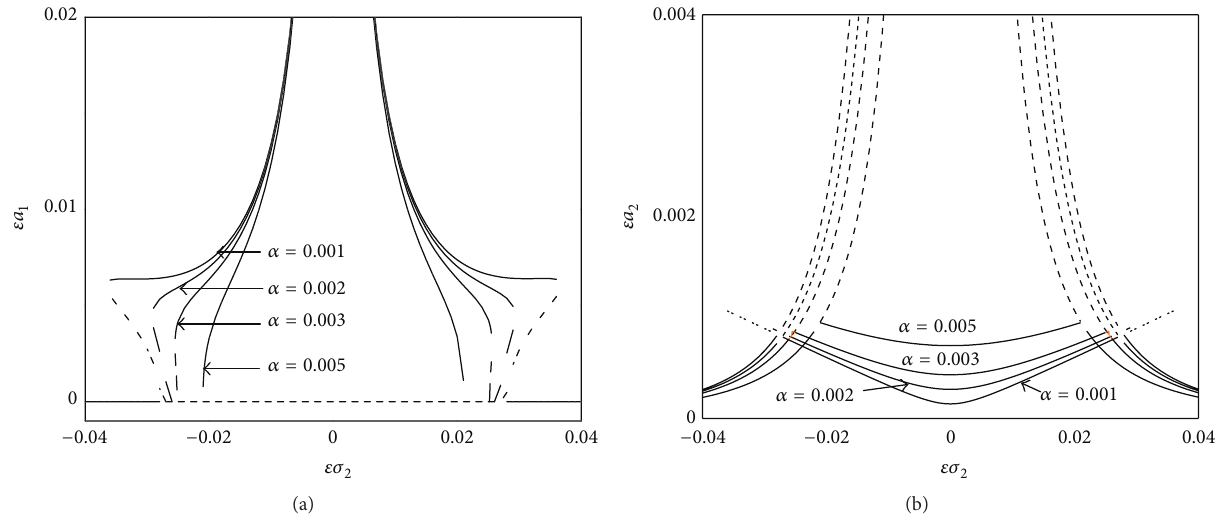
Figure 6: Amplitude-frequency curves of the second superharmonic resonance for different viscosity coefficients: (a) the first mode and (b) the second mode.